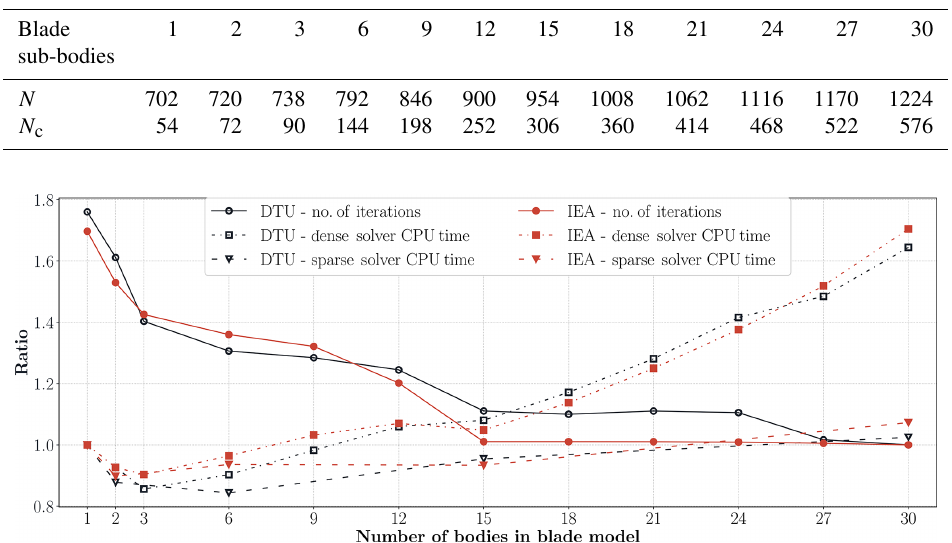
Table 3. Number of generalized coordinates N and constraint equations N c for the full turbine model. The number of sub-bodies refers to the sub-bodies for the different blade models; it does not refer to the total number of sub-bodies of the entire turbine.